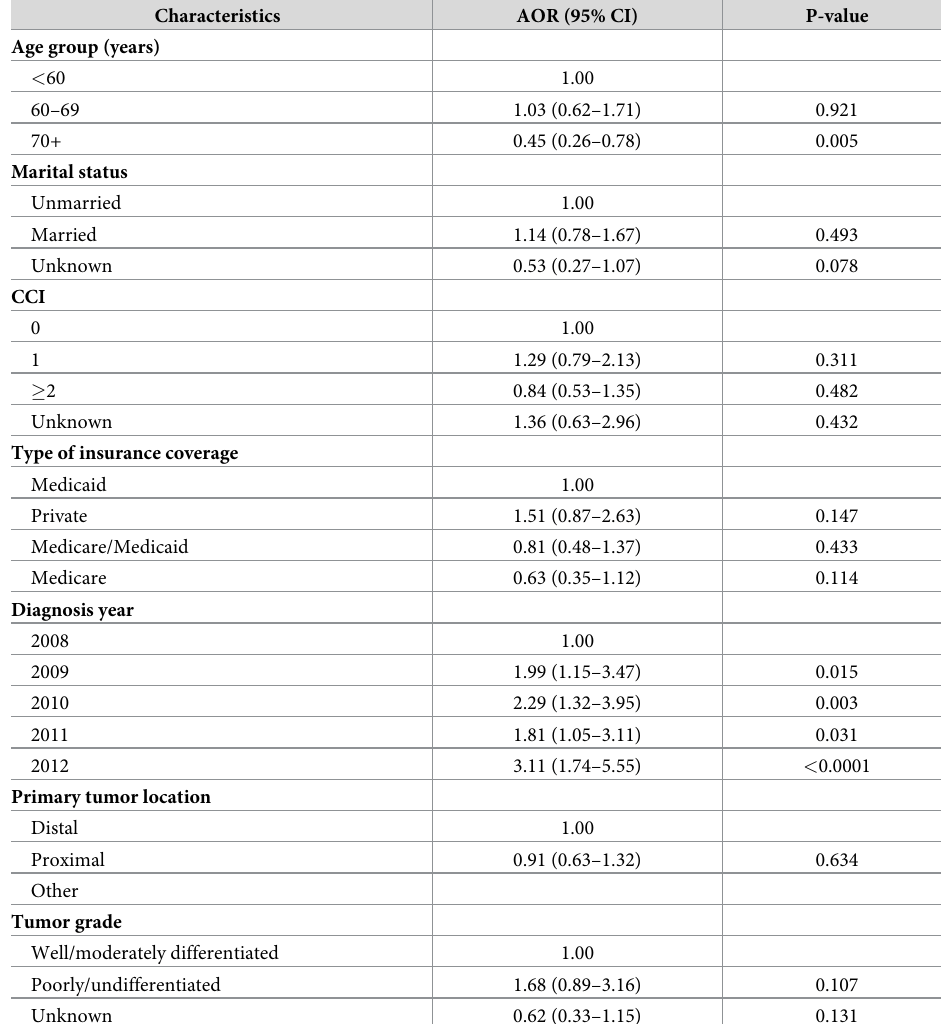
Table 5. Predictors of Receipt